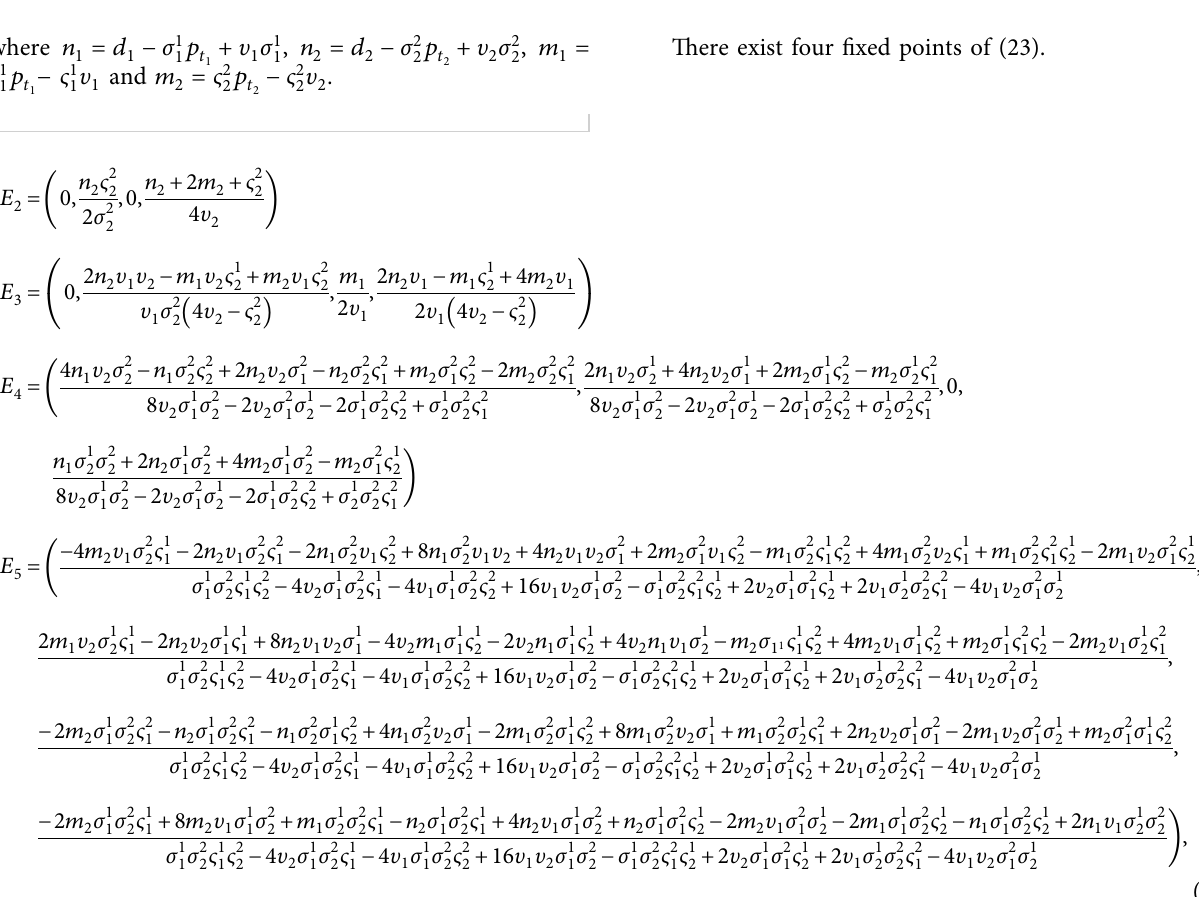
with respect to κ 2